Question: How would you classify this visualization?
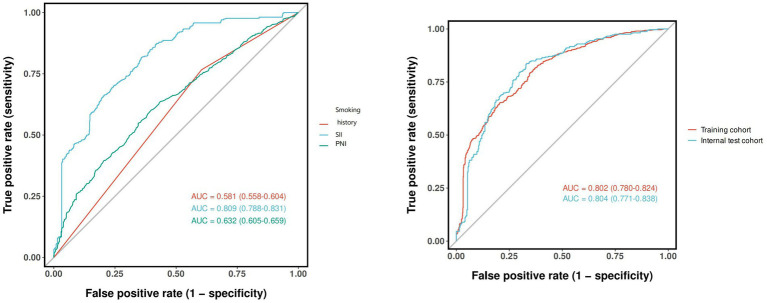
Answer: line